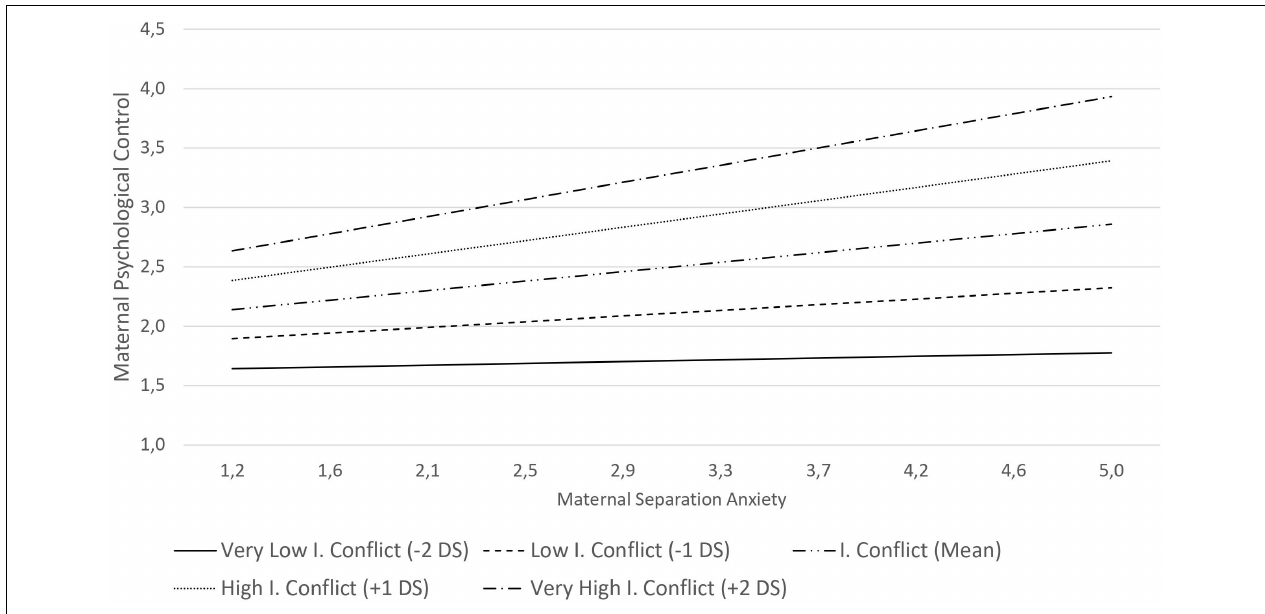
FIGURE 1 | Relations between maternal separation anxiety and maternal psychological control depends on the level of inter-parental (I.)